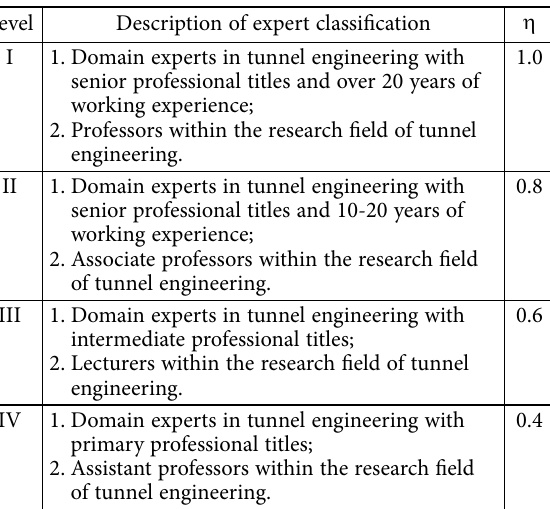
Table 16. Classification of expert judgment ability level and setting of corresponding weights (Zhang et al.,